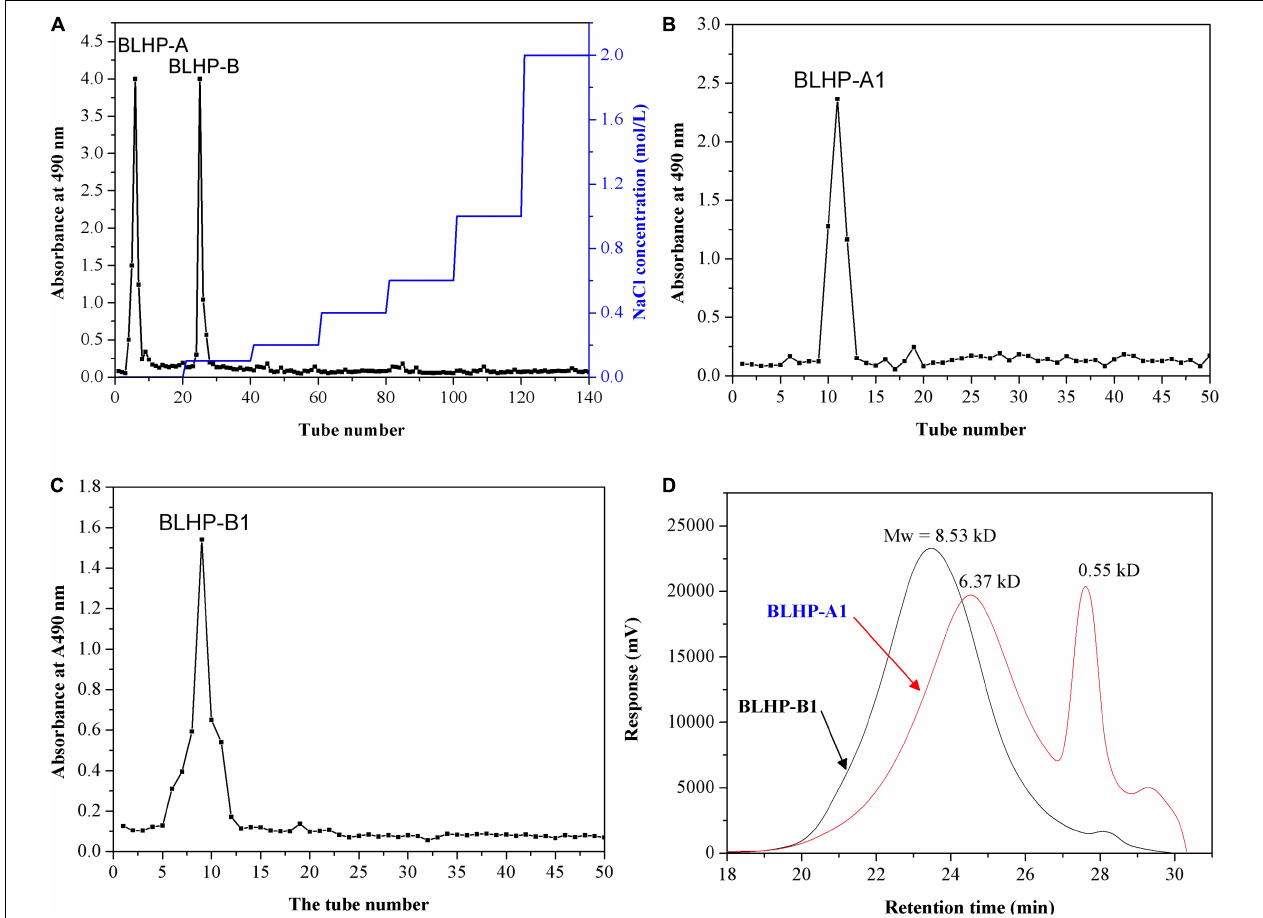
FIGURE 1 | Purification of the BLHP samples: (A) the crude polysaccharides were applied to DEAE-Sepharose fast flow column (2.0 cm × 40 cm, Cl − form) to produce BLHP-A and BLHP-B fractions; (B) DEAE Sephacryl S-300 column (2.0 cm × 40 cm) was applied to purify BLHP-A sample; (C) DEAE Sephacryl S-300 column (2.0 cm × 40 cm) was applied to purify BLHP-B sample; (D) chromatogram of the molar mass distribution of BLHP-A1 and BLHP-B1 detected by GPC.